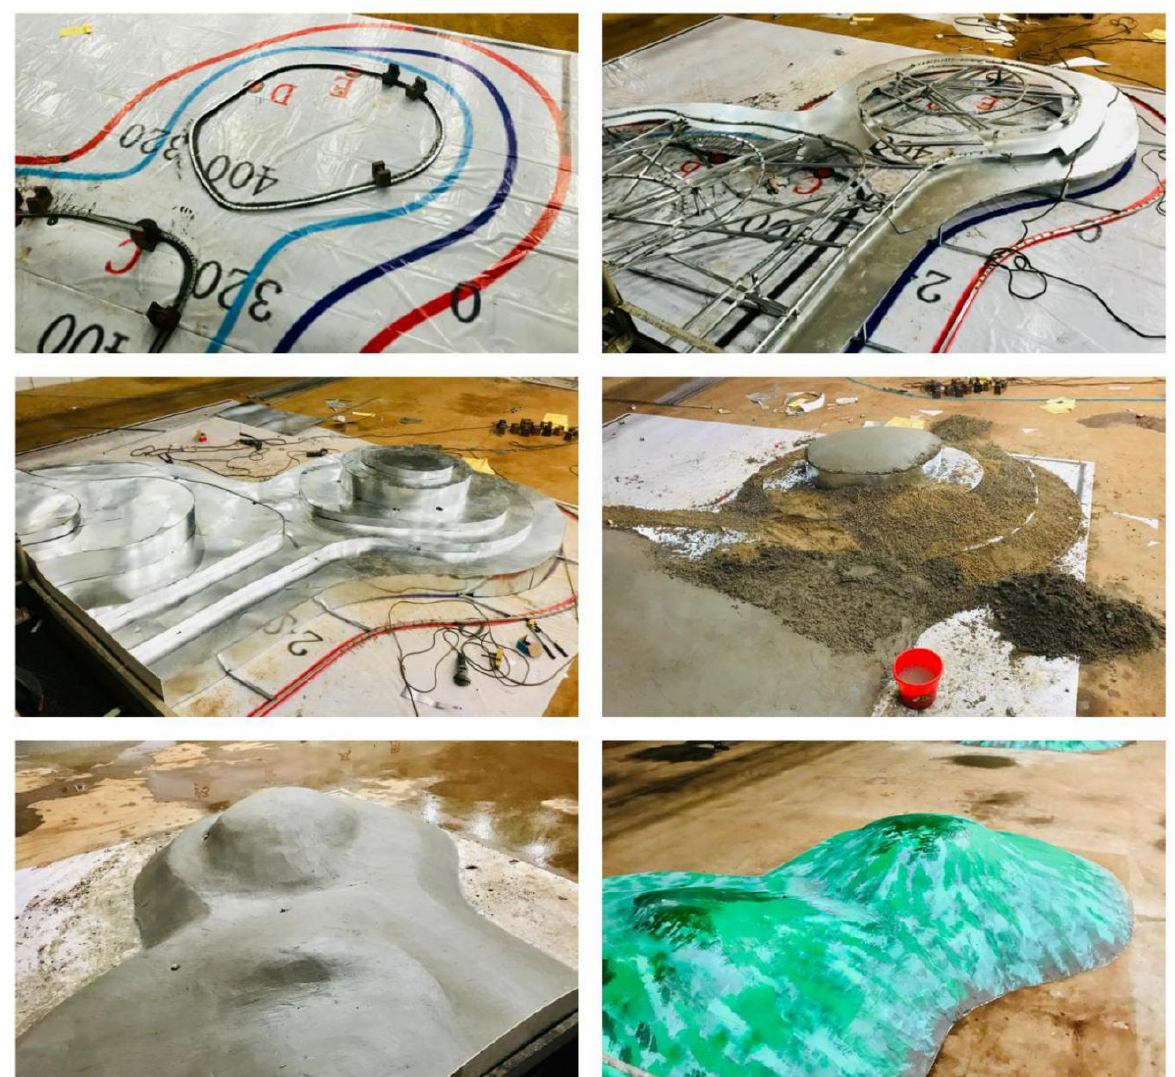
Figure 16. The reef construction process.